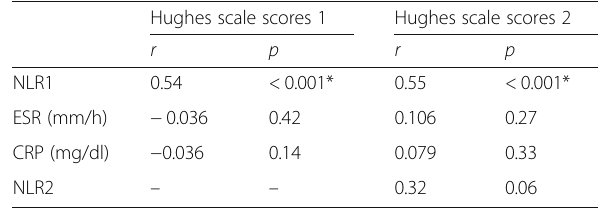
Table 2 The association between clinical characteristic and pretreatment/post-treatment NLR values